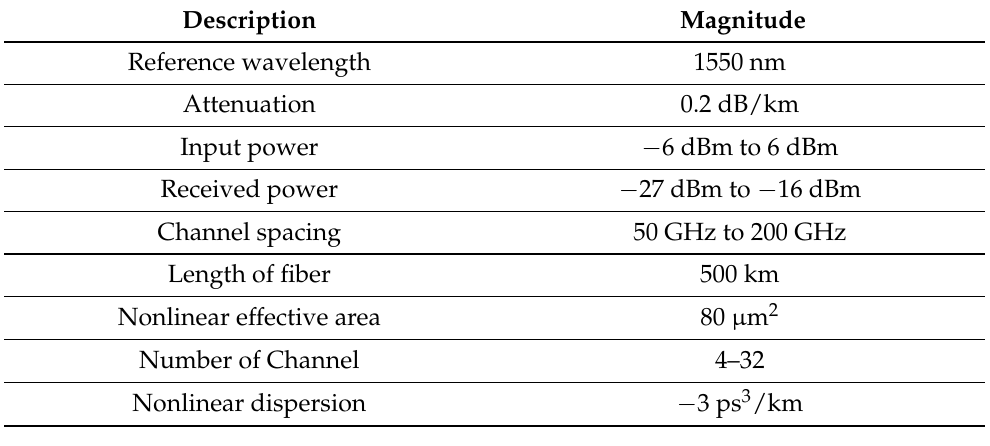
Table 1. Simulation parameters with their values and units.